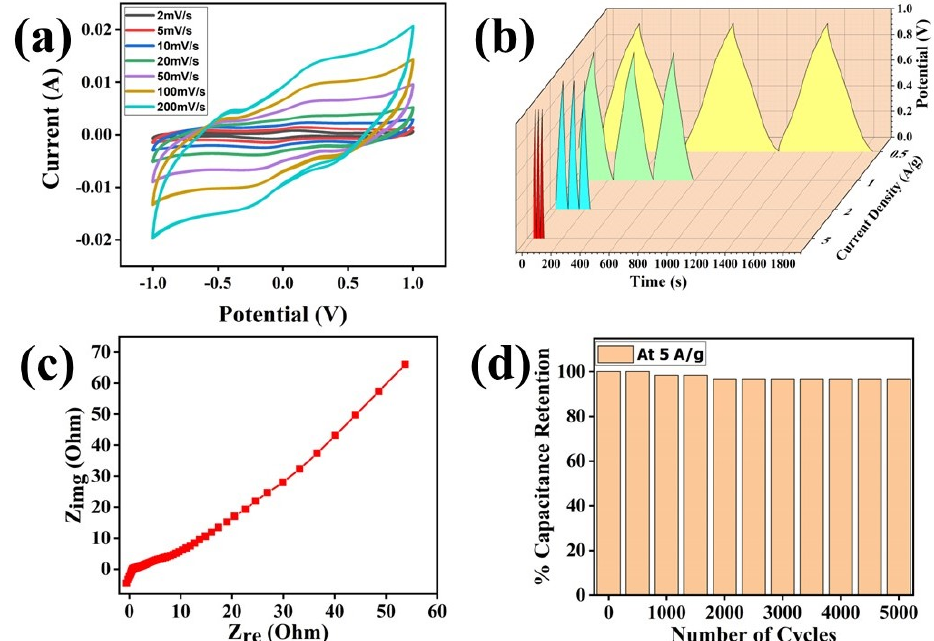
Figure 9. ( a ) Cyclic voltammetry of the thin-film electrode, ( b ) GCD plot of the thin − film electrode, ( c ) EIS plot of the thin − film electrode, ( d ) Specific capacitance retention of the thin − film electrode. Table 1. Specific capacitance calculated using CV plots of the thin electrode device.